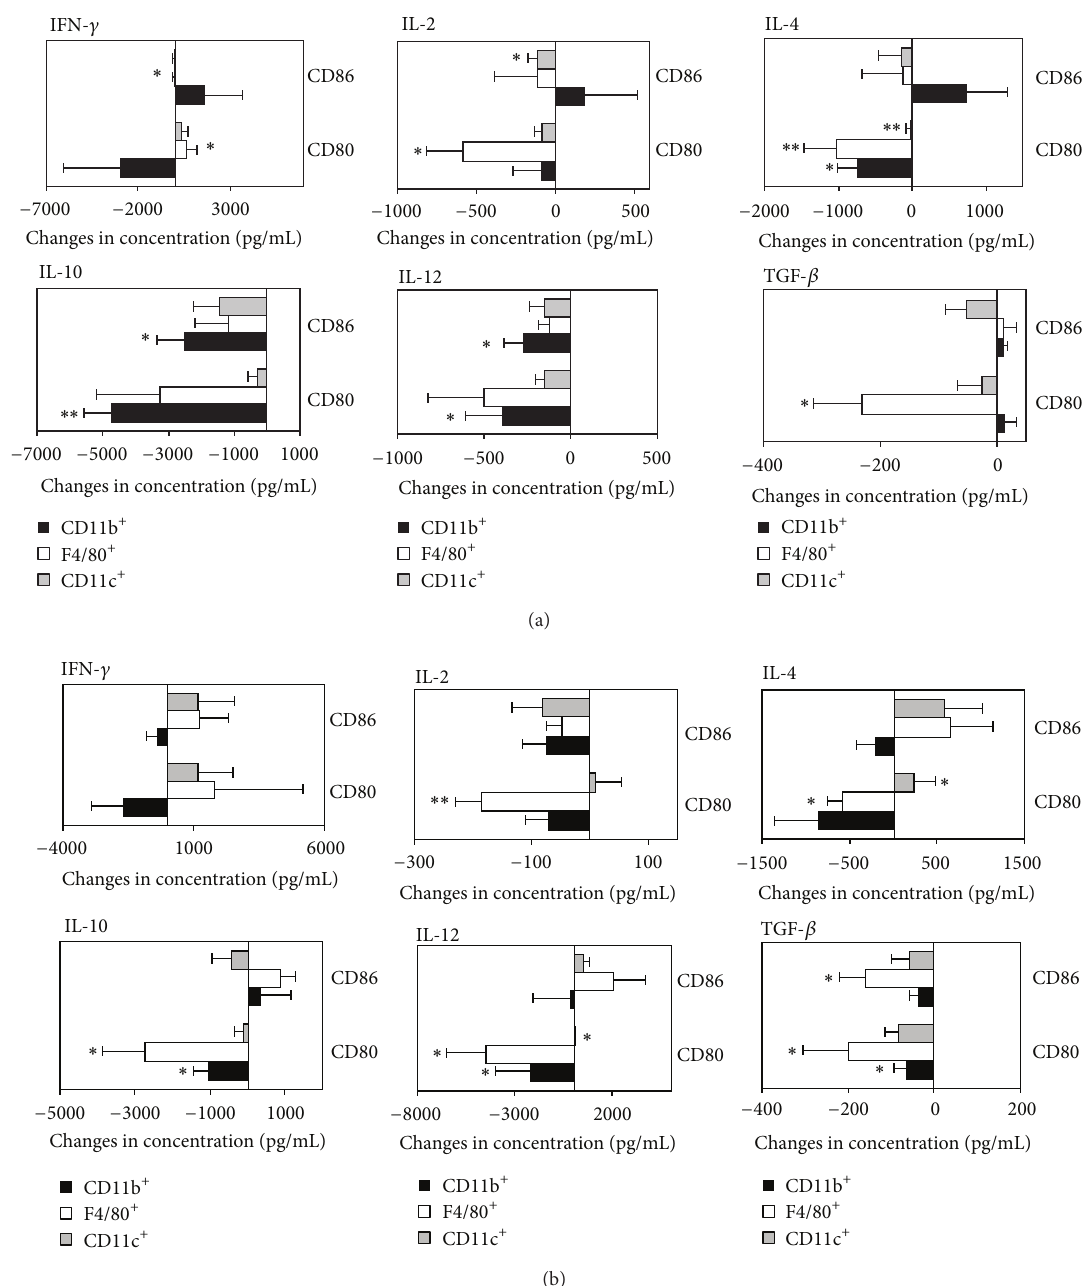
Figure 3: Changes in cytokine profile detected in cocultures of OVA-specific T cells with splenic APCs isolated from pseudopregnant (a) or mated (b) female mice after blockade of costimulatory molecules CD80 and CD86. Data were presented as increase/decrease of concentration in comparison to appropriate isotype control-treated cultures (mean ± SEM). 𝑁 = 10 samples per group. Student’s t -test (parametric) or Wilcoxon (nonparametric) test, ∗ 𝑃 < 0.05 ; ∗∗ 𝑃 < 0.01